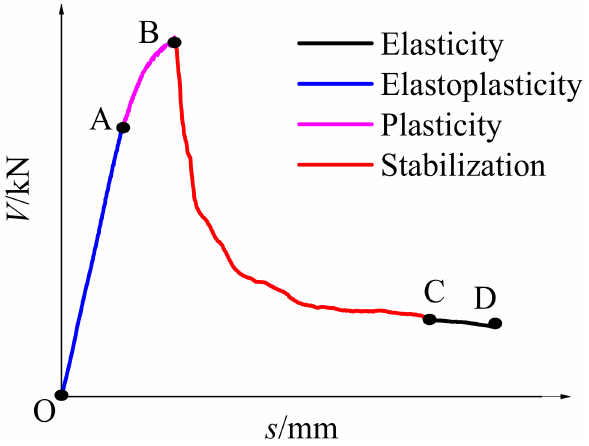
Figure 6. Typical load–displacement curves.